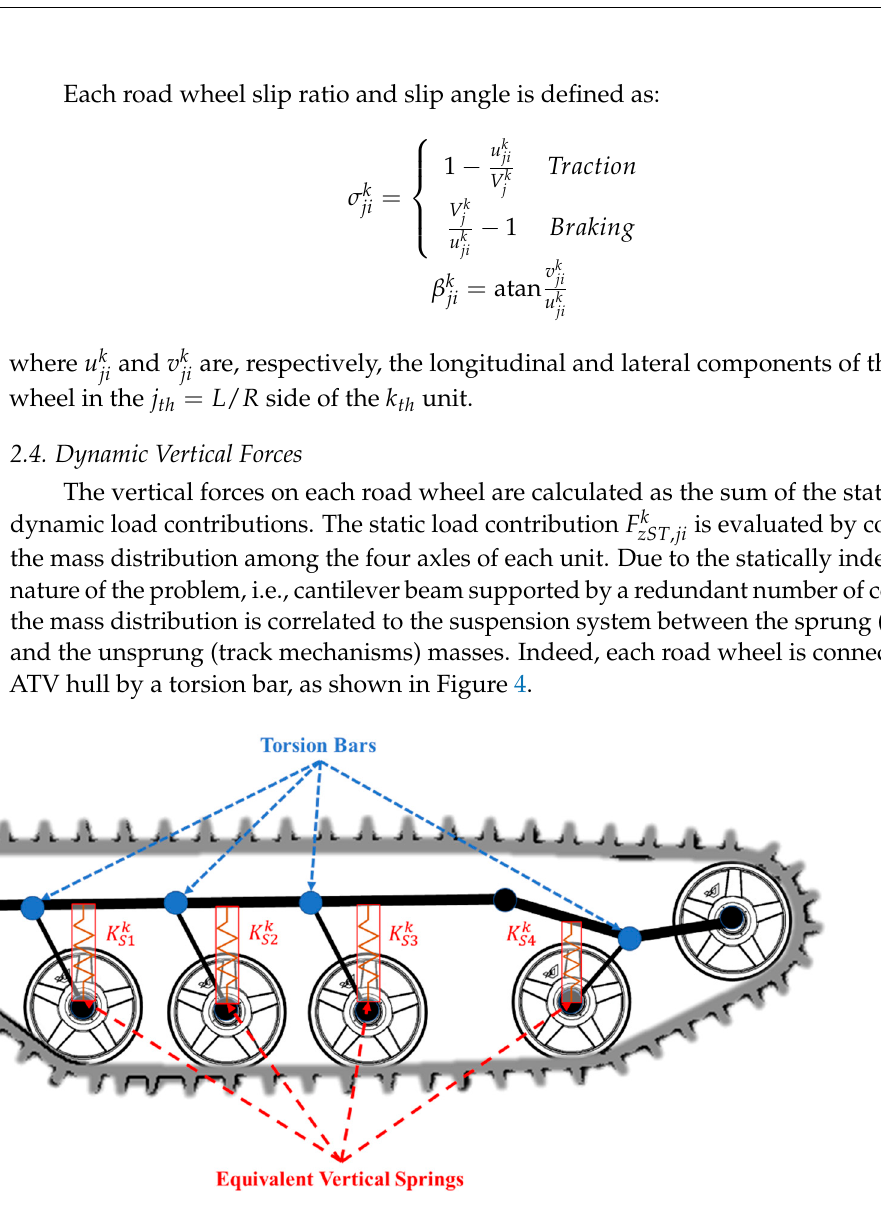
Figure 4. Simplified schematic of the ATV suspension system.